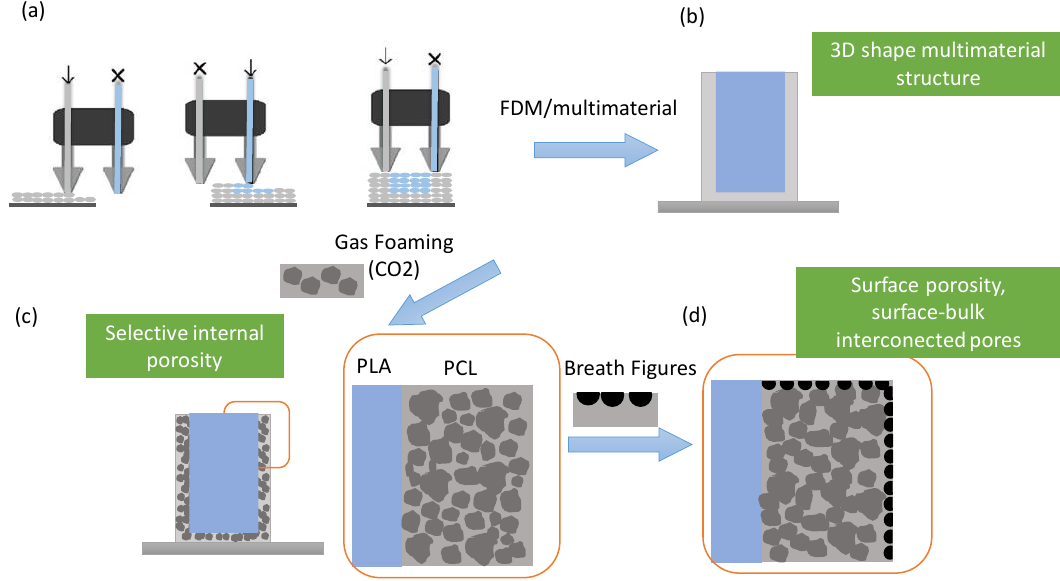
Figure 1. Strategy employed to fabricate 3D multi-material porous scaffolds with internal and external porosity. ( a , b ) Multi-material 3D printing of poly (lactic acid) (PLA)/ poly (ε -caprolactone) (PCL) parts, ( b , c ) foaming of the parts using supercritical CO 2 (SCCO 2 ), ( c , d ) surface porosity formed using the breath figures approach.